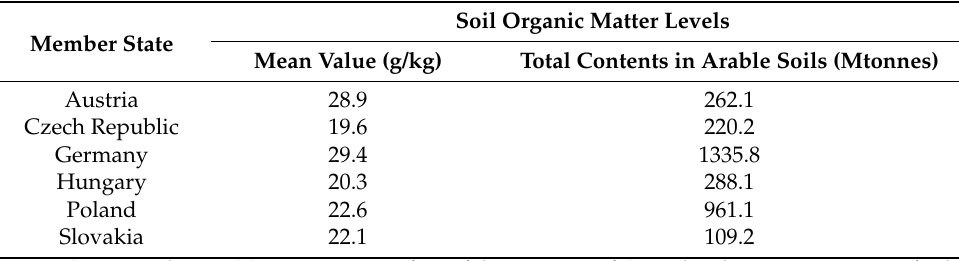
Table 2. Soil organic matter levels in arable soils. Soil Organic Matter Levels Member State Mean Value (g/kg) Total Contents in Arable Soils